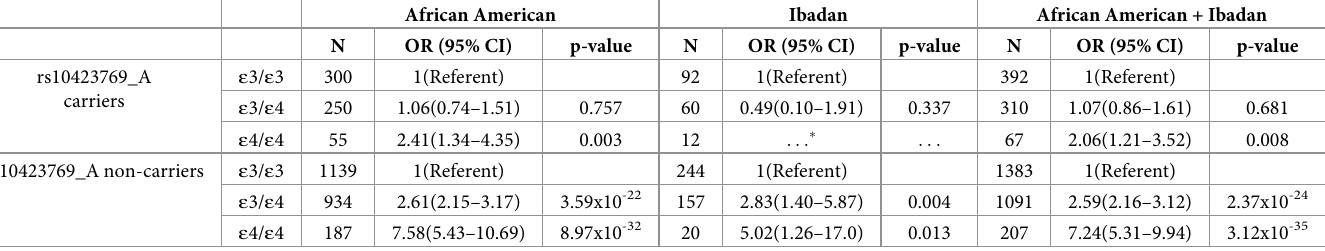
Table 2. Odds Ratios for developing Alzheimer disease according to ApoE genotypes ε 3/ ε 4 and ε 4/ ε 4 relative to the ε 3/ ε 3 stratified by the rs10423769_A allele and